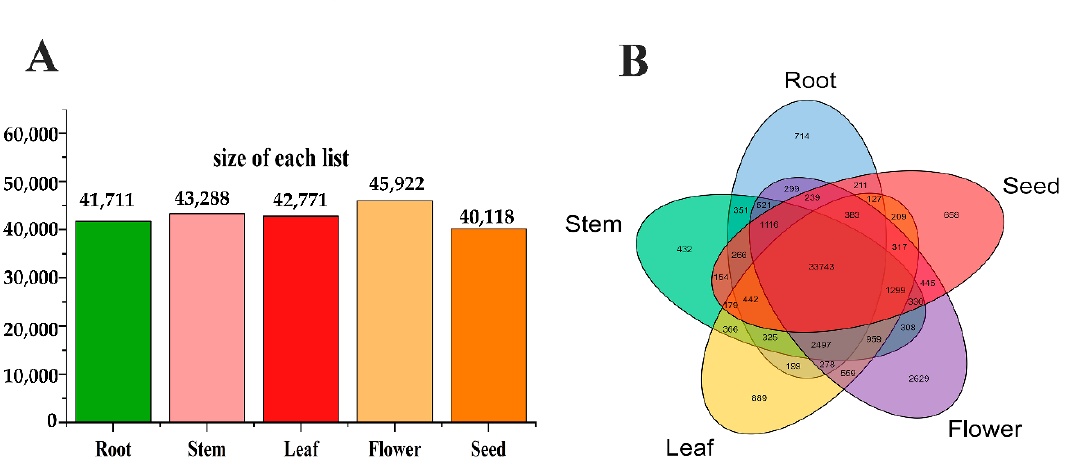
Figure 1. Specially expressed genes across five various organs of C. obtusifolia . ( A ) The gene profiles of five various organs. ( B ) Venn diagram for the organ ‐ specific transcripts. Table 1. PacBio libraries and sequencing results.